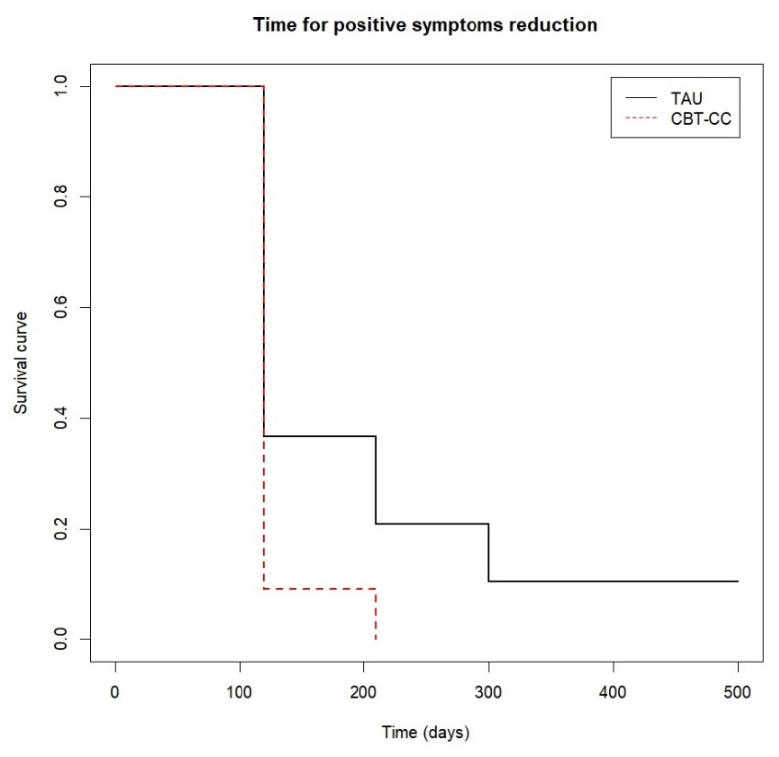
Figure 3. Time to positive psychotic symptoms reduction.